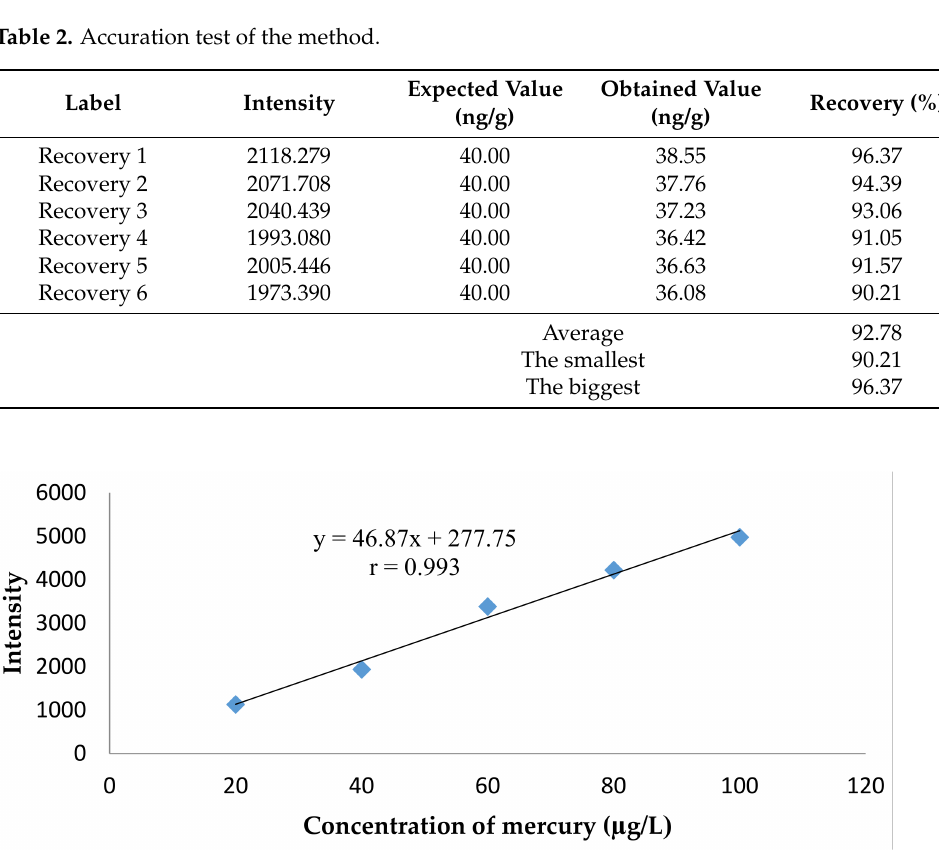
Figure 4. The result of linearity test method.